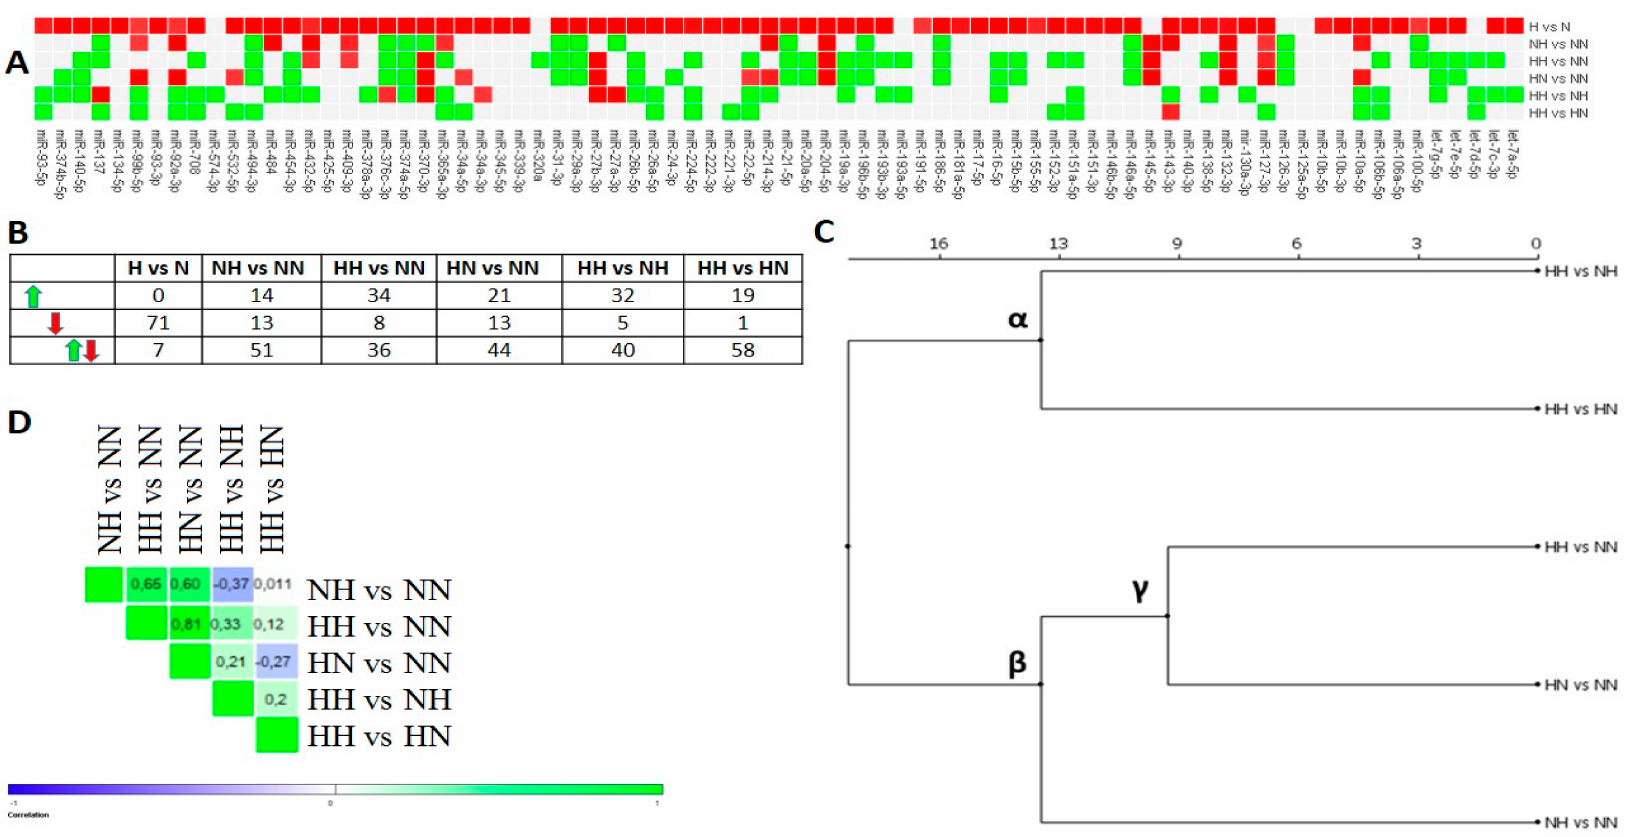
Figure 3. miRNAs expression changes evoked by chronic and intermittent HG in pAds and differentiated Ads, based on FC values. ( A ) The heat map diagram shows the expression changes of examined miRNAs in pAds and differentiated Ads exposed to HG. Red denotes an expression decline (FC < − 1.5), green indicates an expression increase (FC > 1.5) and grey shows no changes. ( B ) Table depicts the numerical summary of miRNAs changes from the heat map in ( A ). ( C ) Euclidean hierarchical clustering of studied comparisons. ( D ) Heat map shows positive (green) and negative (blue) Pearson’s correlation values for pairwise comparisons of variants of differentiated Ads exposed to a single or double stimulus of